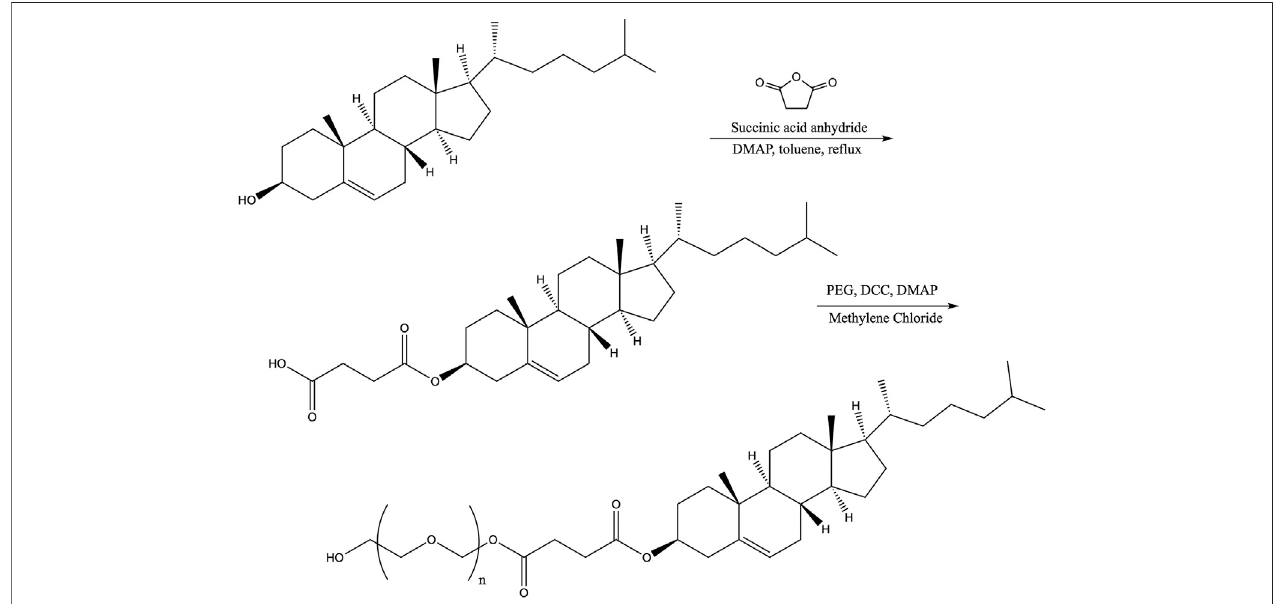
FIGURE 1 | Synthesis reaction scheme used in this work for carboxyethyl-PEG derivatives of hydroxylated hydrophobic moiety donors (shown here with cholesterol and succinic anhydride).